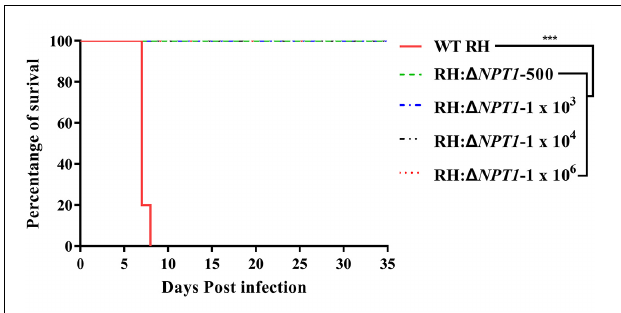
FIGURE 2 | Survival curves of Kunming mice infected with the wild-type T. gondii (RH) strain or the RH: (cid:49) NPT1 strain. The different groups of Kunming mice were challenged with 1 × 10 3 tachyzoites of the wild-type strain and doses of 500, 1 × 10 3 , 1 × 10 4 , 1 × 10 6 parasites of the RH: (cid:49) NPT1 strain. Each group included 10 mice, and the survival time was recorded for 35 days after the challenge ( n = 10; ∗∗∗ P < 0.001; n.s. , not significant;